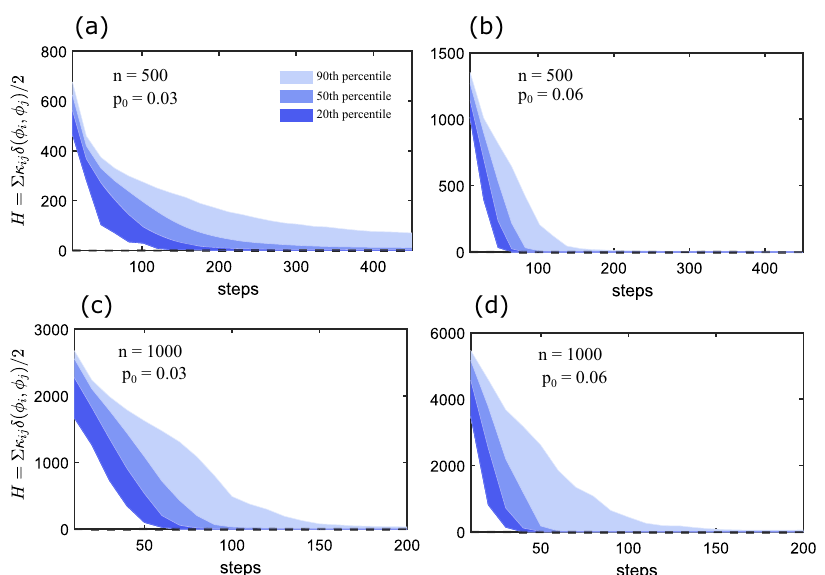
Fig. 5 Adiabatic gain method applied to the Potts-3 problem. Solution to the Potts-3 ( q = 3) problem on randomly generated ensembles of 3-colorable graphs of size n = 500 ( a , b ) and n = 1000 ( c , d ) nodes and with average edge density of p 0 = 0.03 ( a , c ) and p 0 = 0.06 ( b , d ). The edge weights κ ij are uniformly set to 1 for all the edges. For all panels, 100 random graphs are generated and each case is simulated with 100 random initial conditions to obtain the distribution of the energies H = ∑ κ ij δ ( ϕ i , ϕ j )/2 (where κ ij is the coupling strength of the i th and j th oscillators and ϕ i is the i th oscillator ’ s steady-state phase) based on 10,000 data points for a given number of iterations. In all cases, the gain is linearly increased from g = 0 to g = 2.5, while the time-step size is Δ =